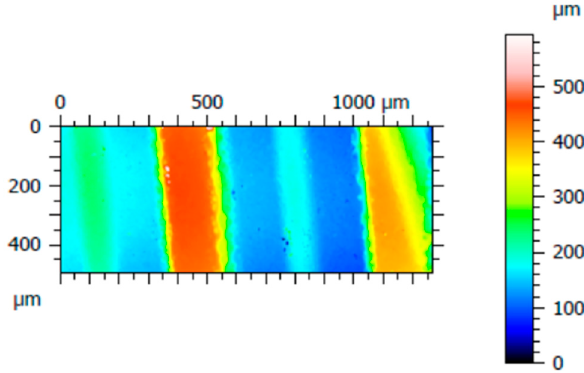
Figure 3. An acquired surface of implant D, with dimensions of 1.27 mm × 0.5 mm.